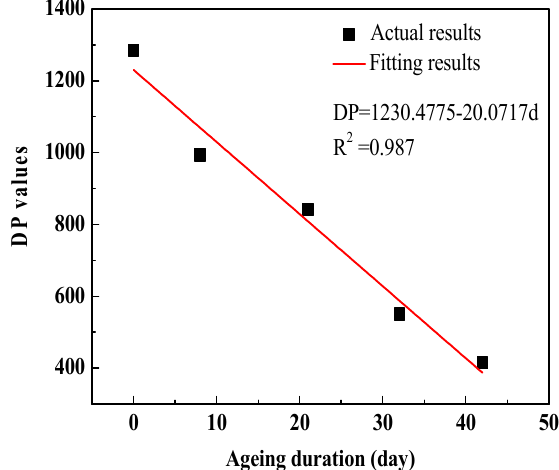
Figure 3. Test results of degree of polymerization (DP) values of unaged and aged polymer pressboard specimens.